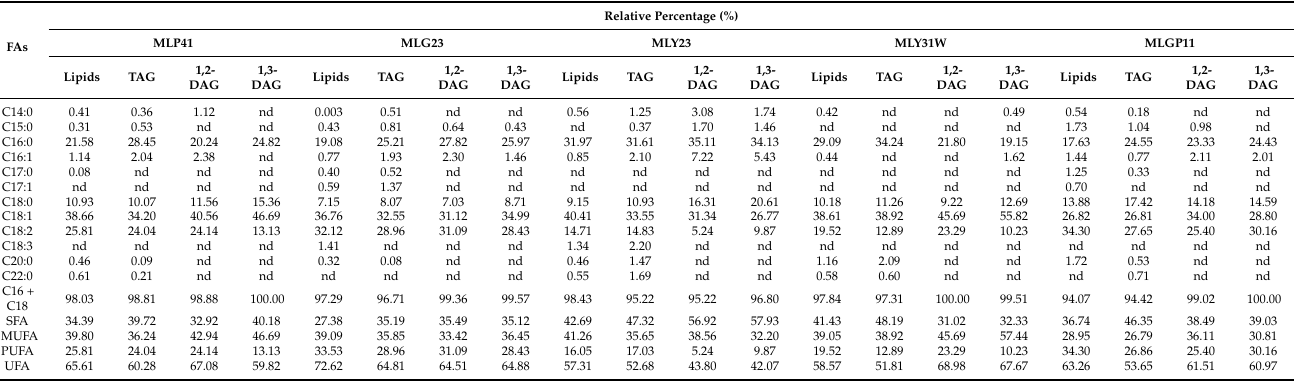
Table 2. FA compositions of crude lipids and their DAG and TAG components from the five screened endophytic